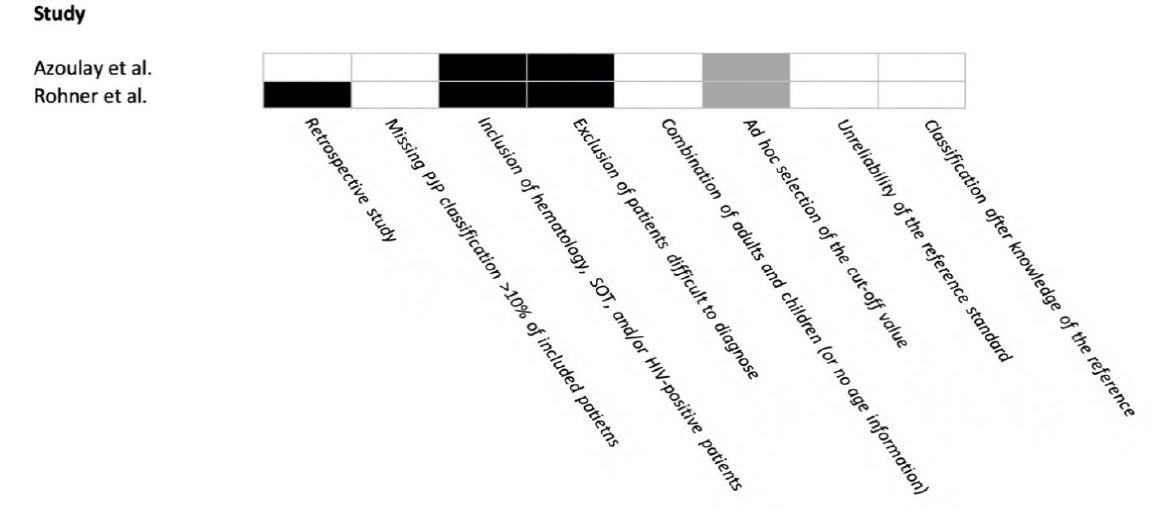
Figure 2. Risk of bias in included studies for Pneumocystis jirovecii pneumonia. Risk of bias: present = black; absent = white; not applicable =